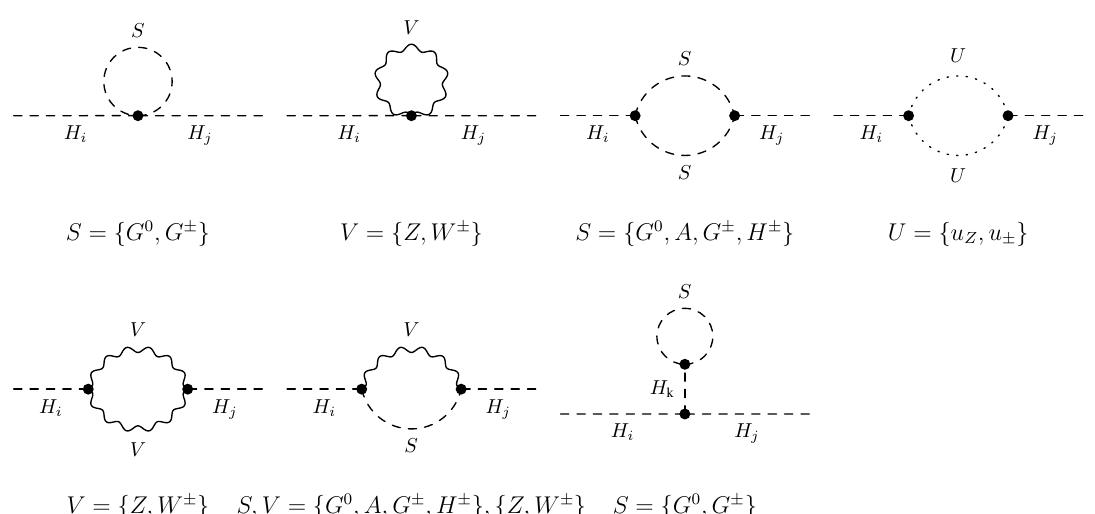
Figure 13 . All Feynman diagrams contributing to the gauge dependence of the CP-even self- energies (cid:6) tad ( p 2 ). For the tadpole diagram, a sum over intermediate Higgs states H k ( k = 1 ; 2 ; 3) H i H j is assumed. Note that the ghost and vector boson contributions in the tadpole diagrams precisely cancel against each other, so that these are not